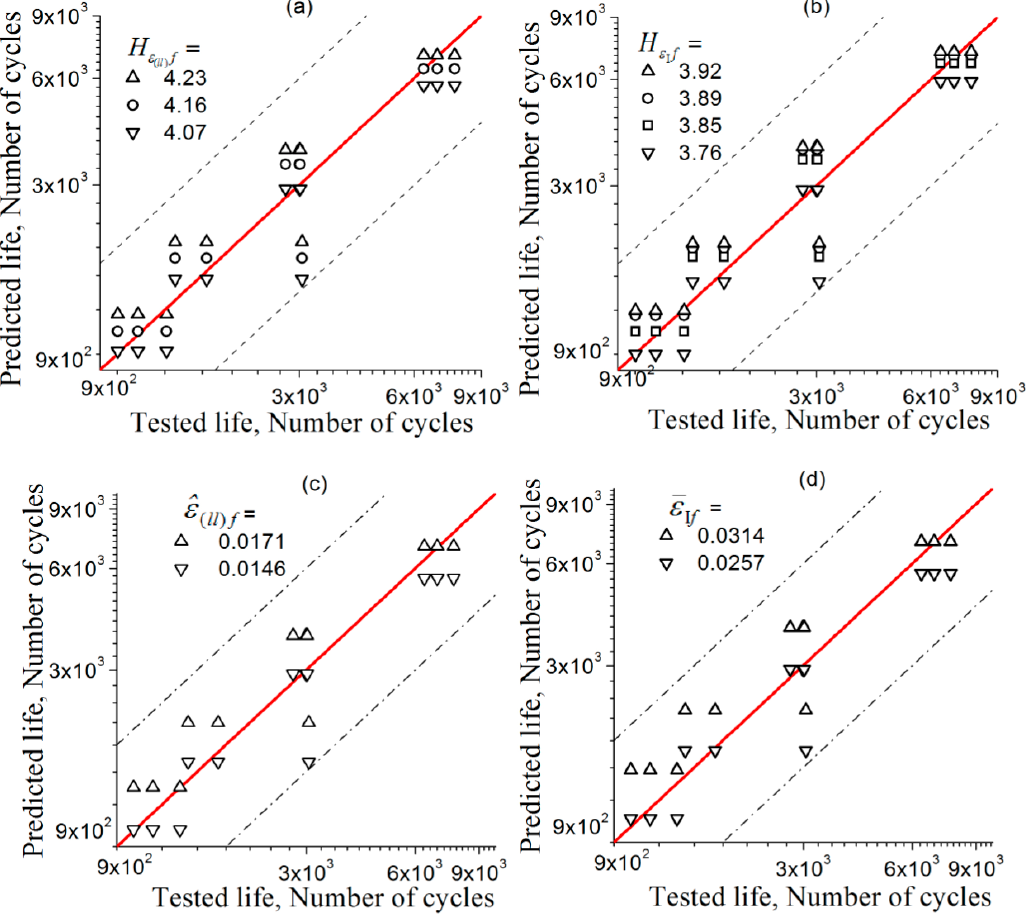
Figure 7. Error assessment between the fatigue lives predicted by various FIPs and the fatigue life tests, the predictions respectively based on: ( a ) H ε